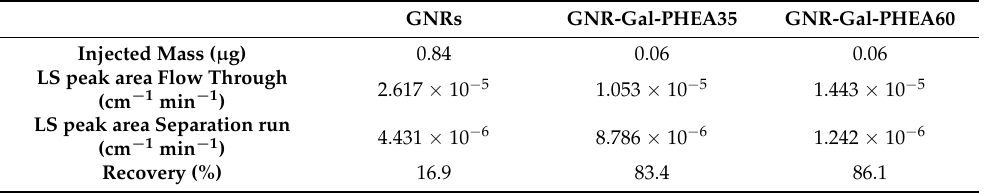
Table 5. Recovery of bare and glycoconjugated GNRs. The data are calculated from AF4-MALS